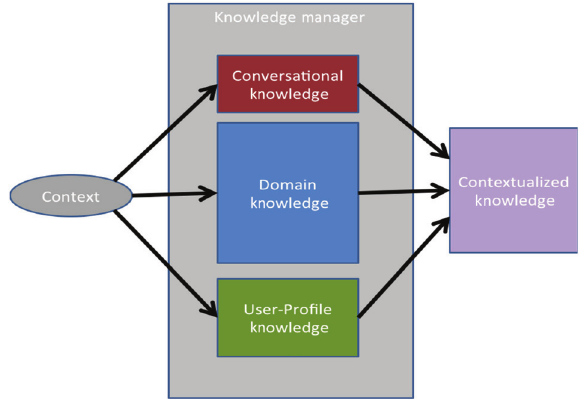
Figure 29. Knowledge Manager Block